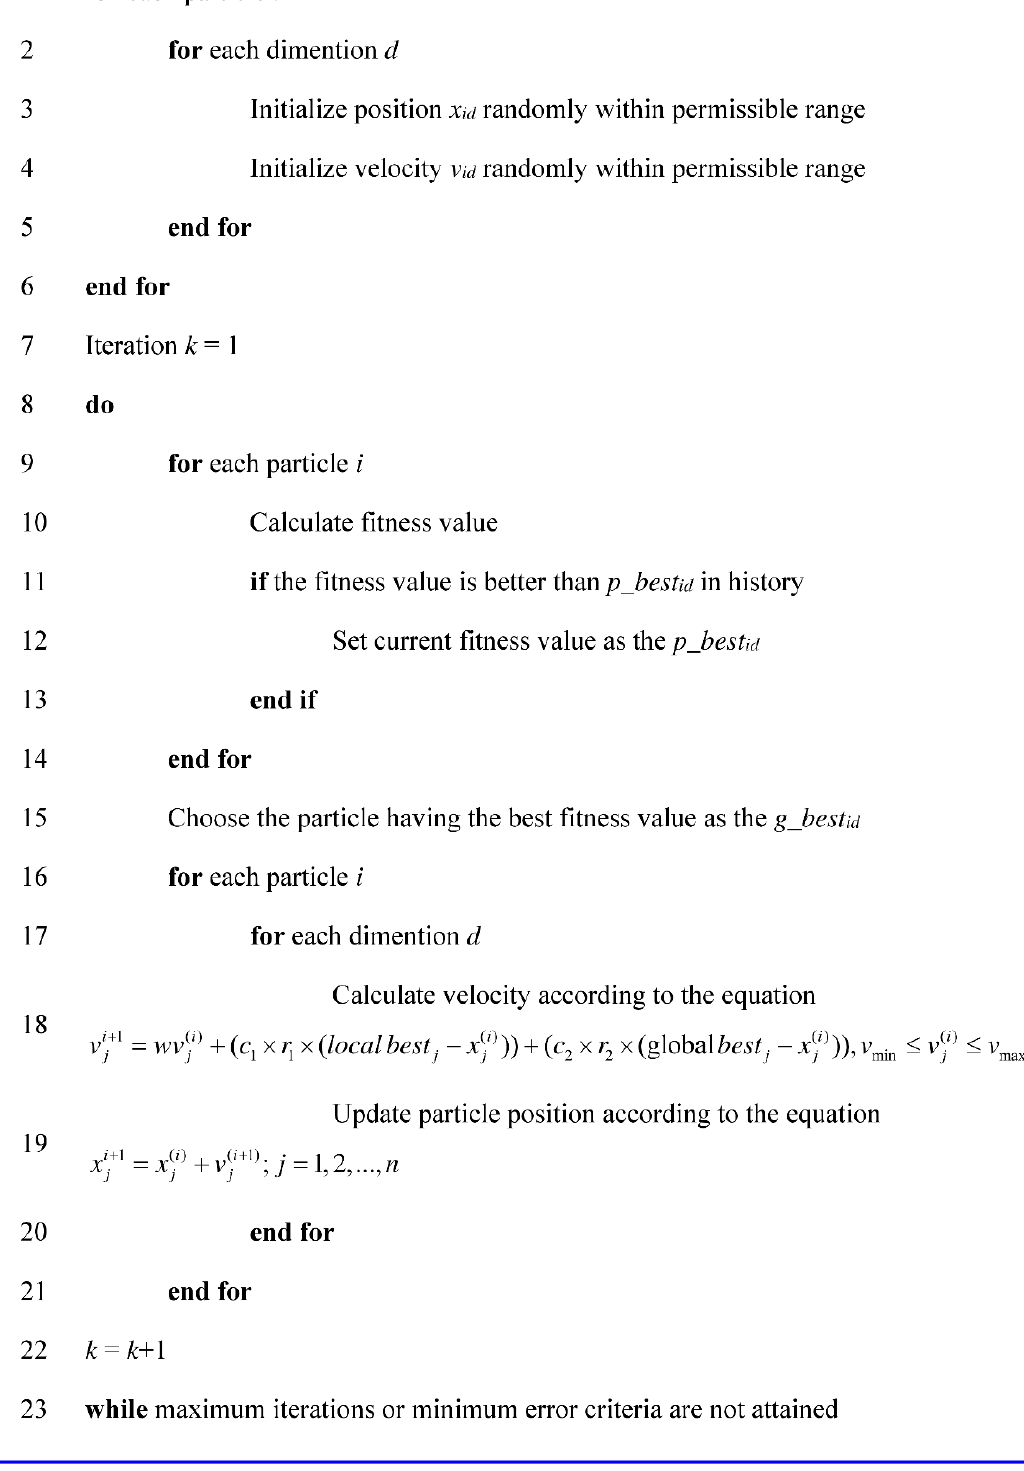
Figure 3. The particle swarm optimization (PSO) pseudo-code for the optimization process [50].